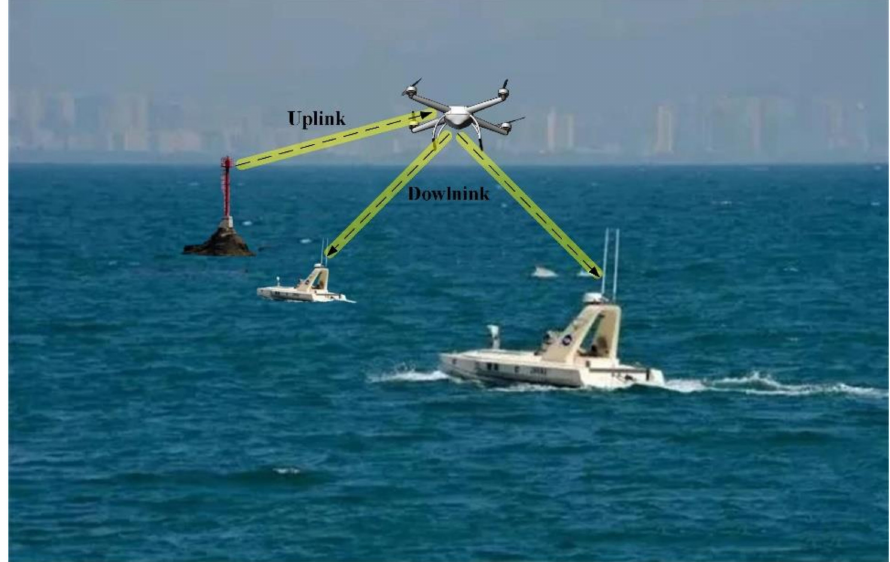
Figure 15. UAV–sea surface OWC scenario, arrows indicate the direction of data